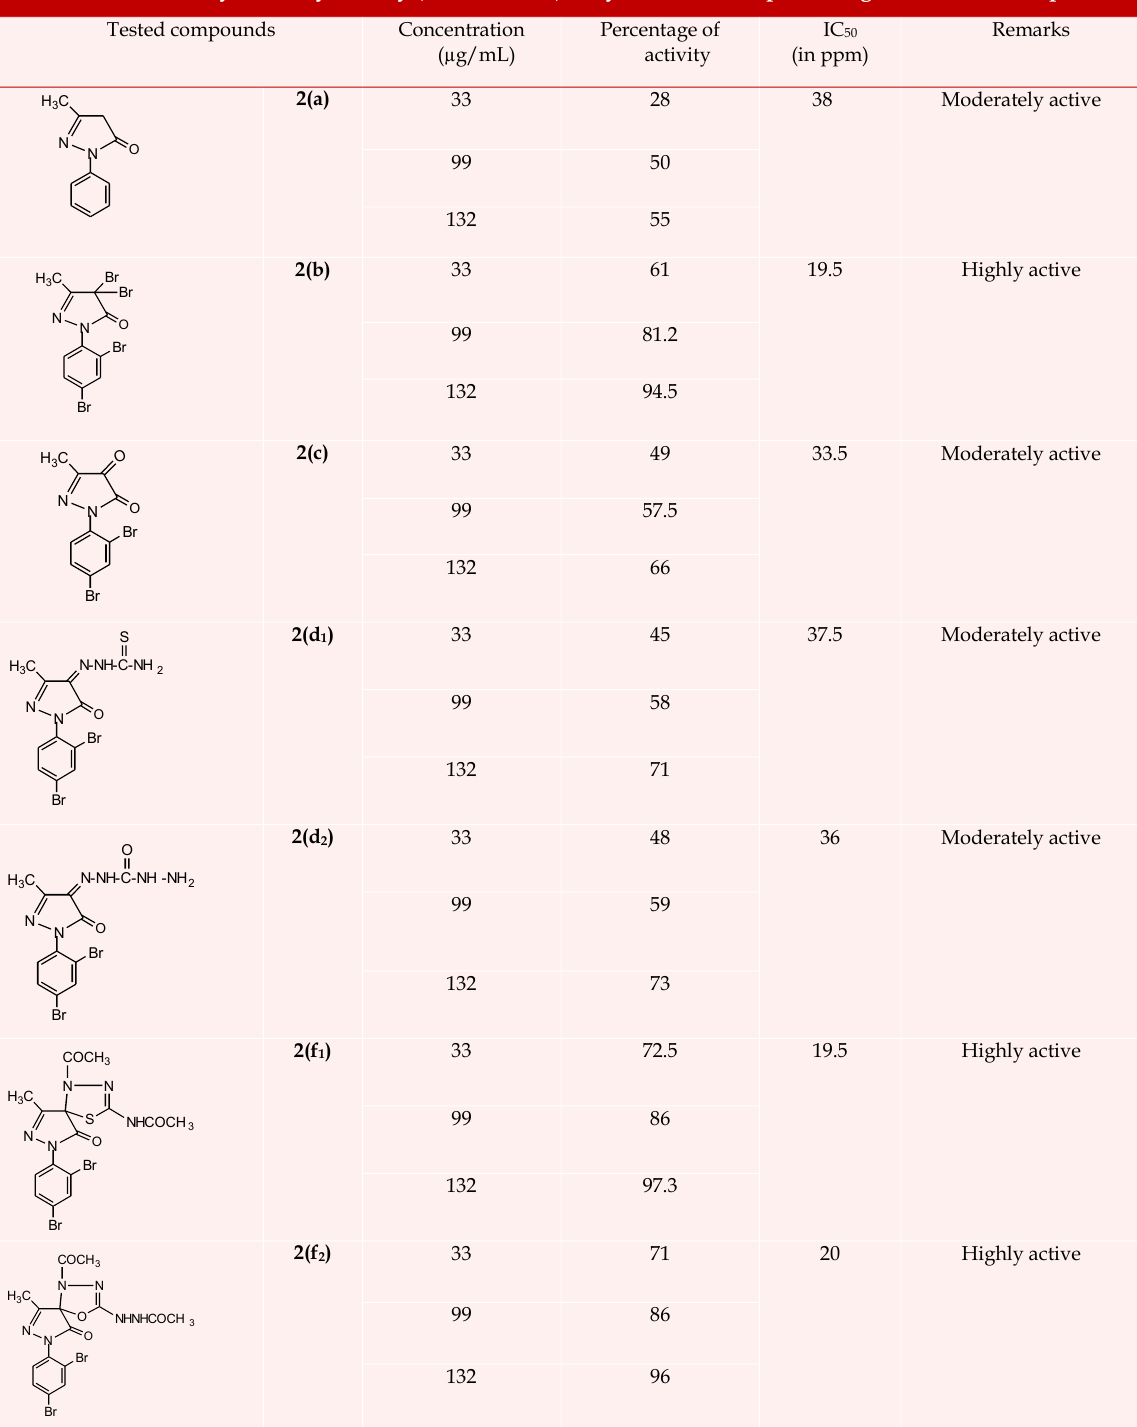
The result of cytotoxicity activity (IC 50 24 hours) of synthesized compounds against brine shrimp Tested